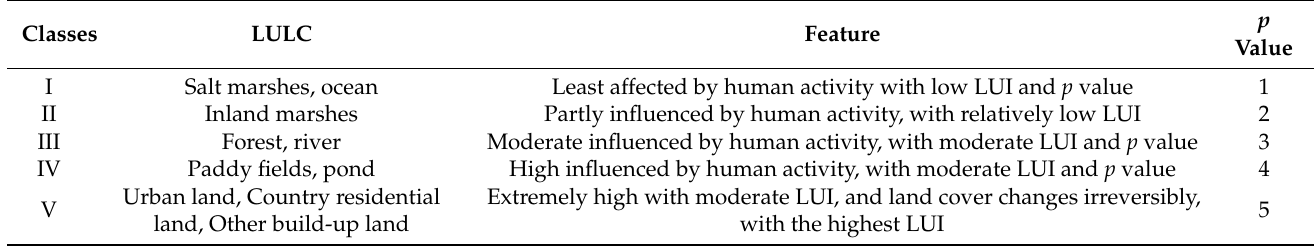
Table A1. Classification of land use intensity.